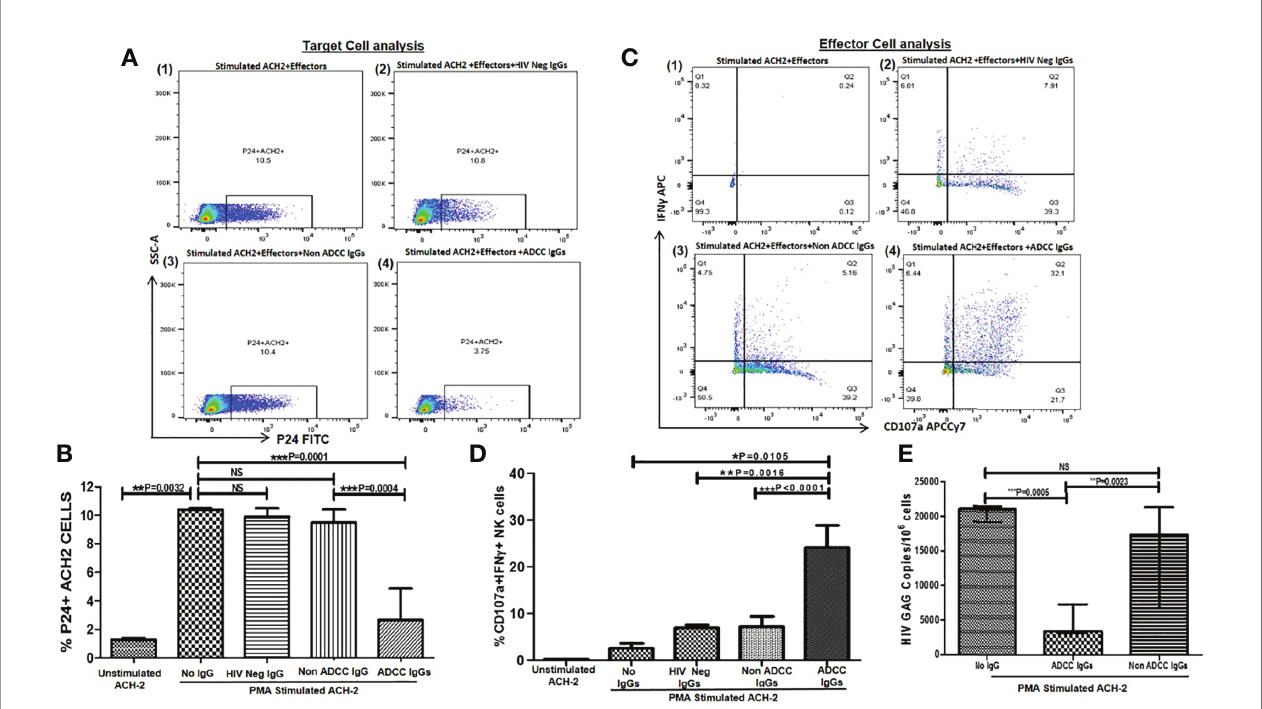
FIGURE 1 | ADCC activity against reactivated ACH-2 cells. (A) The representative dot plots show % p24+ACH-2+ cells (X axis) in (1) PMA stimulated ACH2 with PBMCs (as a source of effector: Nk cells) without antibody (2), after addition of HIV Neg IgGs or (3) non-ADCC IgGs or (4) ADCC IgGs. (B) The bar diagram shows frequency of the p24+ACH2 cells (Y axis) in unstimulated ACH-2 control, after PMA stimulation, after addition of HIV Neg IgGs (n = 5), non-ADCC IgGs (n = 11), and ADCC IgGs (n = 14)(X axis). (C) The representative dot plots show NK cells (effectors from PBMC of HIV negative healthy individual) expressing IFN g (on Y axis) and CD107a expression (on X axis) in (1) PMA stimulated ACH2 with PBMCs without antibodies (2), after addition of HIV Neg IgGs or (3) non-ADCC IgGs or (4) ADCC IgGs. (D) The bar graph shows frequencies of CD107a and INF g secreting NK cells (on Y axis) in unstimulated ACH-2, after PMA stimulation, after addition of HIV Neg IgGs, non-ADCC IgGs or ADCC IgGs (on X axis). (E) The bar diagram shows HIV gag DNA copies per million cells in ACH-2 cells (on Y axis) after PMA stimulation, after addition of ADCC IgGs and non-ADCC IgGs (on X axis). NS, not signi fi